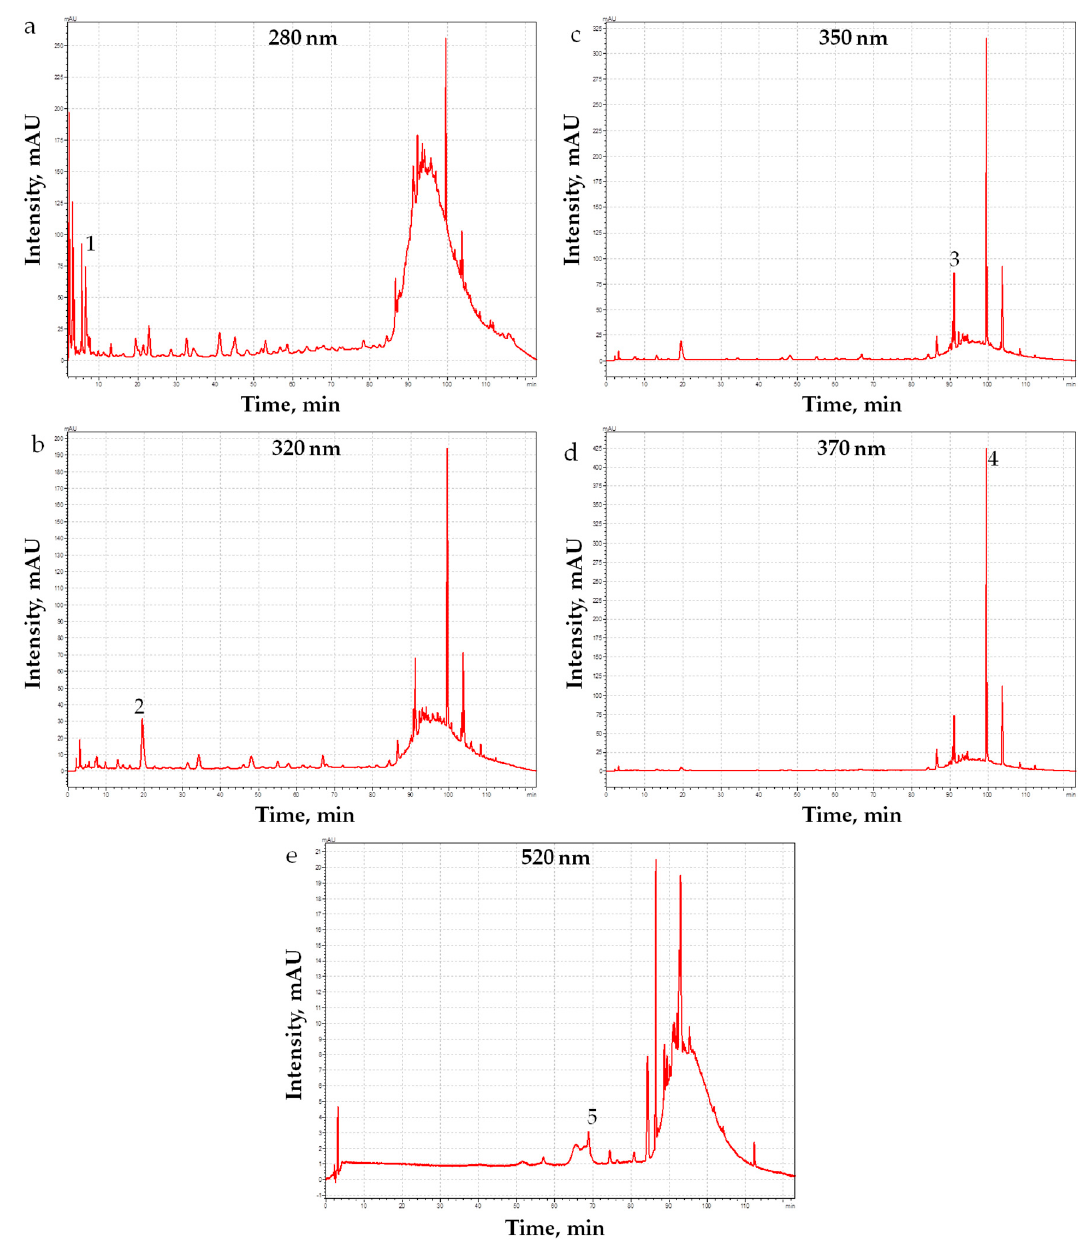
Figure 2. HPLC analysis of PRPE of Nebbiolo grape. Chromatograms at di ff erent wavelength: ( a ) 280, ( b ) 320, ( c ) 350, ( d ) 370, and ( e ) 520 nm are reported. Numbers indicate the peaks of the identified polyphenols: (1) gallic acid (280 nm), (2) caftaric acid, (3) rutin (350 nm), (4) quercetin (370 nm) and (5) malvidin-3-glucoside (520 nm) [45].